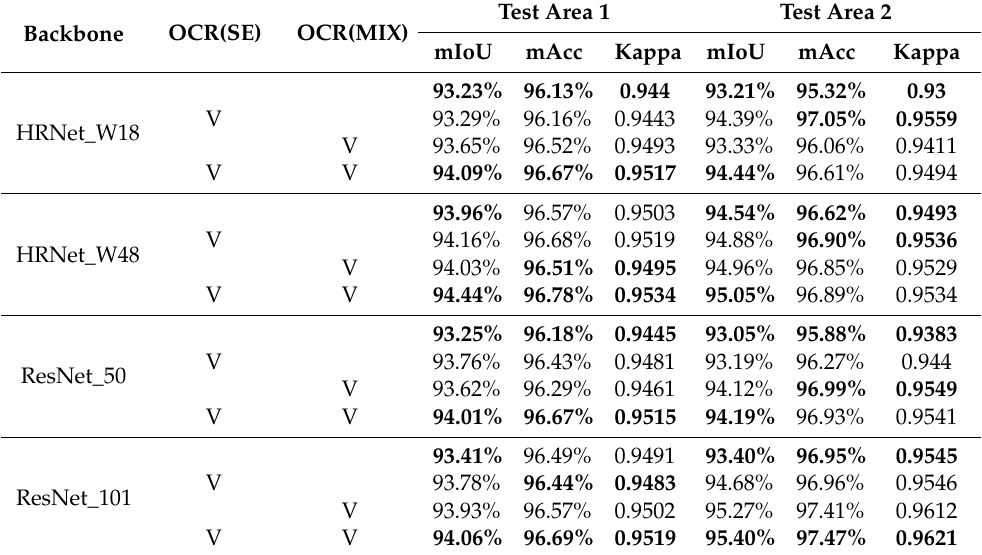
Table 4. Comparison of accuracy results of different changes to OCRNet in test area 1 and test area